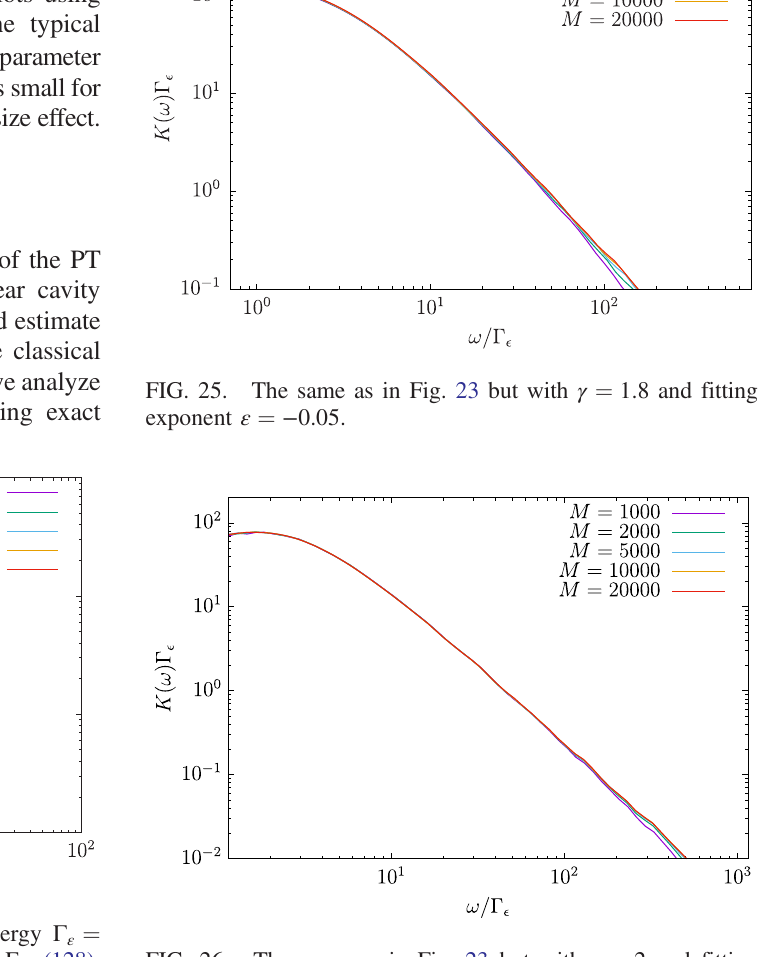
FIG. 26. The same as in Fig. 23 but with γ ¼ 2 and fitting exponent ε ¼ − 0 . 055